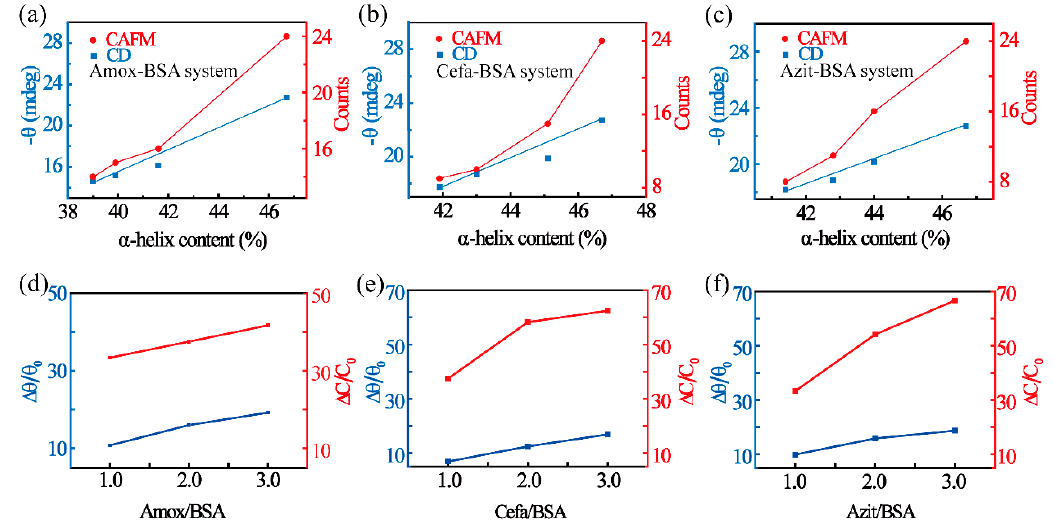
Figure 6. The CD curves and counts of currents within >6 nA in Amox-BSA system ( a ), Cefa-BSA system ( b ) and Azit-BSA system ( c ). The schematic of the relation between magnitude of relative ellipse degree ( θ ) and counts (C) change in Amox-BSA ( d ), Cefa-BSA ( e ) and Azit-BSA ( f )